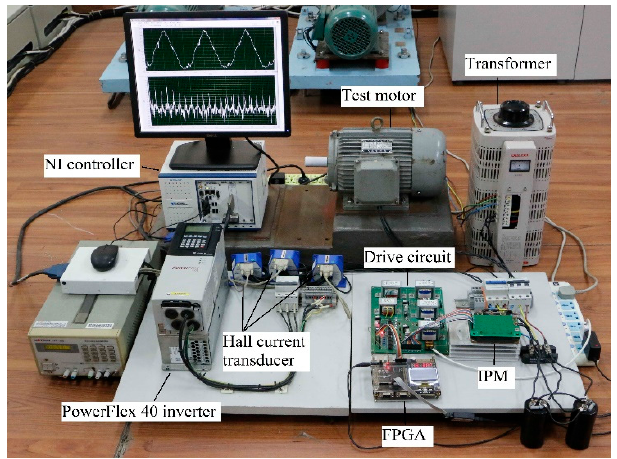
Figure 13. The picture of experimental platform.